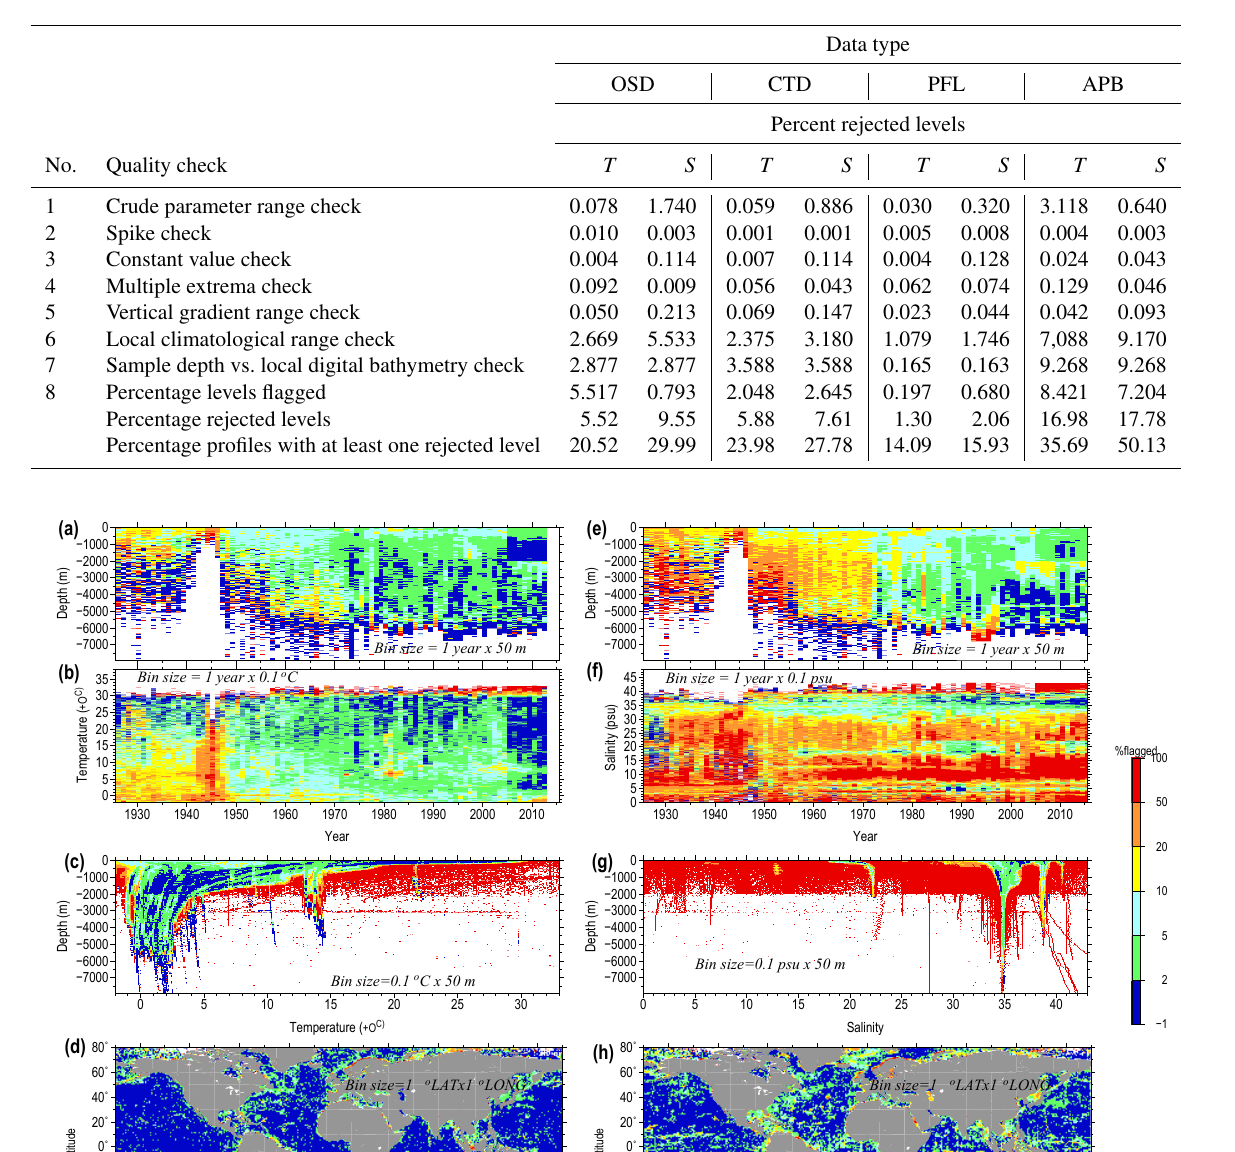
Table 2. Data rejection rate for the automated quality control procedure.